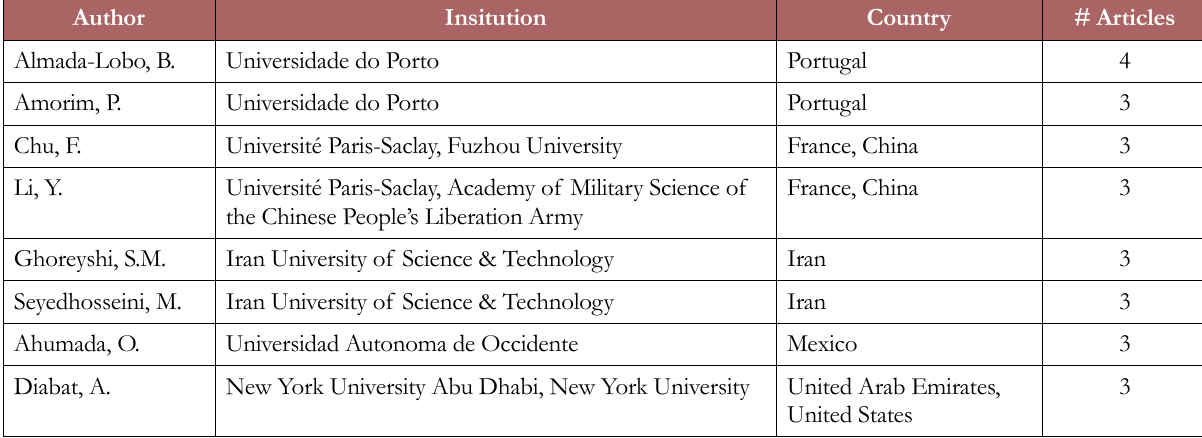
Table 7. Top contributing